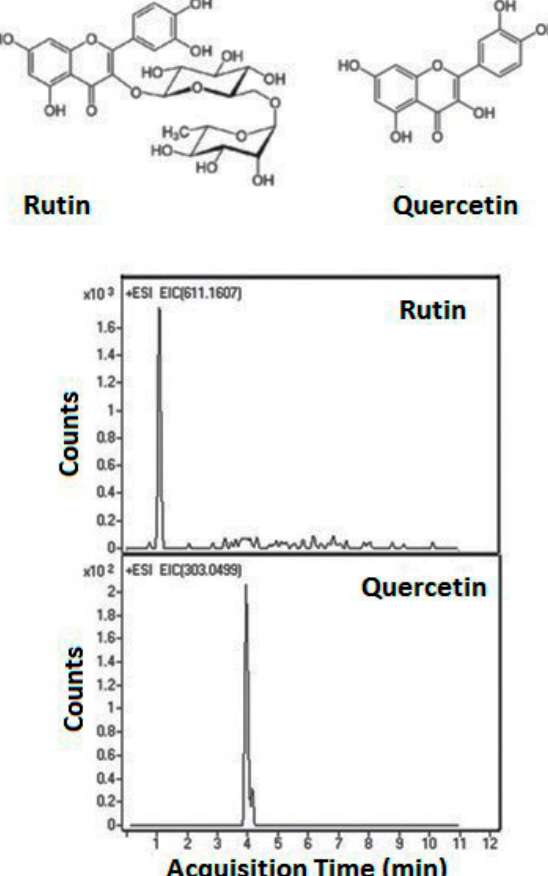
Figure 8. Analysis of the polyphenols rutin and quercetin on the Diamond Hydride column in the aqueous normal-phase mode. Adapted from Reference [66].